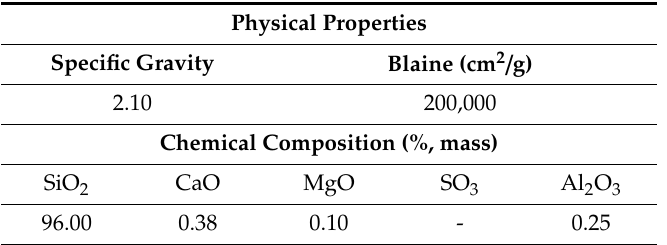
Table 2. Physical and chemical properties of the used silica fume.